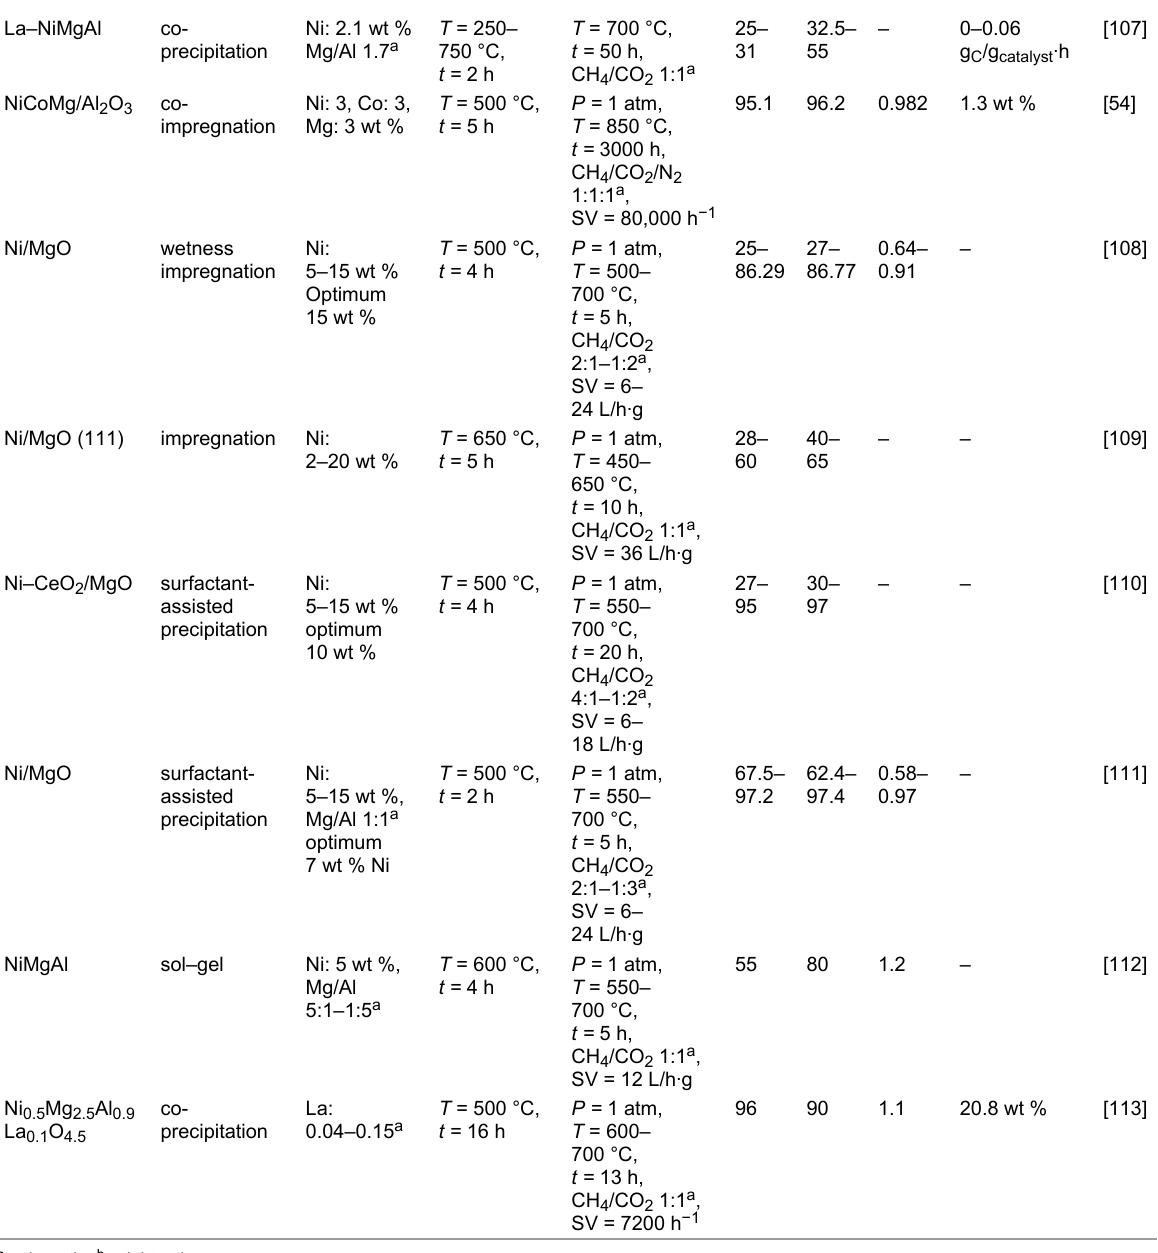
Table 3: Literature summary on the development and process conditions of Mg-containing oxide catalysts in DRM. PM: Preparation method; W: metal loading; CC: calcination conditions; RC: reaction conditions; SV: space velocity. (continued)